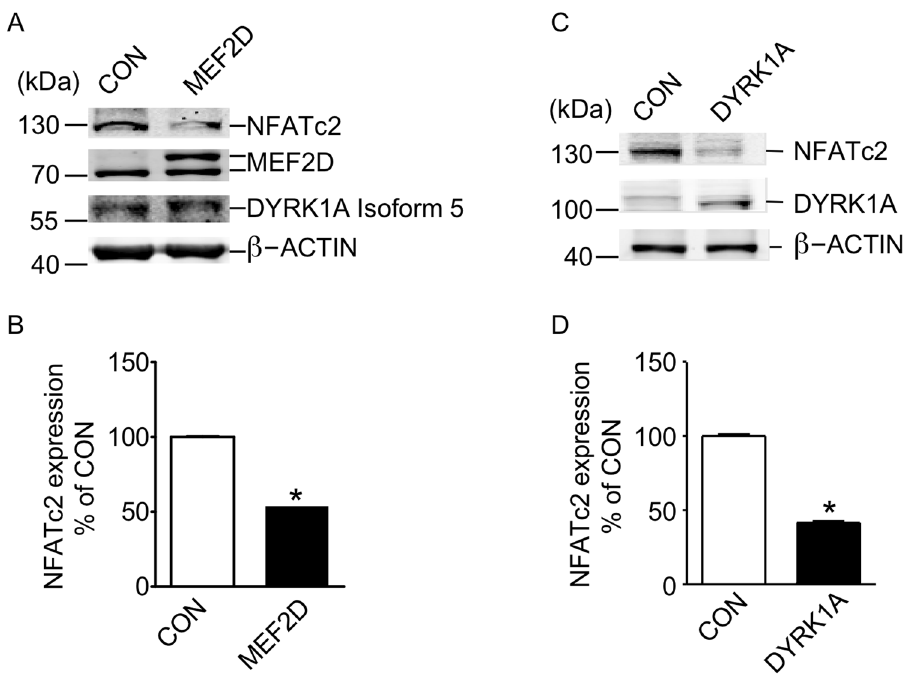
Figure 6. MEF2D regulates DYRK1A kinase activity exemplified by NFATc2 protein expression. ( A ) MEF2D increased DYRK1A protein and decreased NFATc2. MEF2D expression plasmid and empty vector were transfected into T98G cells with NFATc2 expression vector. NFATc2 was detected with anti-HA antibody. MEF2D was detected with anti-MEF2D antibody (610774, BD, San Jose, CA, USA). DYRK1A isoform 5 was detected with anti-DYRK1A antibody (ab156818, Abcam, Shanghai, China). β -actin detected by β -actin monoclonal antibody (SAB1403520; Sigma-Aldrich, Saint Louis, USA) was used as loading control. ( B ) Quantification of A. Values represent means ± SEM; n = 3; * P < 0.01 by Student’s t test. ( C ) DYRK1A decreased NFATc2 protein level. DYRK1A expression plasmid and empty vector were transfected into T98G cells with NFATc2 expression vector. NFATc2 was detected with anti-NFATc2 monoclonal antibody (MA1–025, ThermoFisher, Waltham, USA). DYRK1A was detected with anti-DYRK1A antibody (ab156818, Abcam, Shanghai, China). β -actin detected by β -actin monoclonal antibody (SAB1403520; Sigma-Aldrich, Saint Louis, USA) was used as loading control. ( D ) Quantification of C . Values represent means ± SEM; n = 3; * P < 0.01 by Student’s t